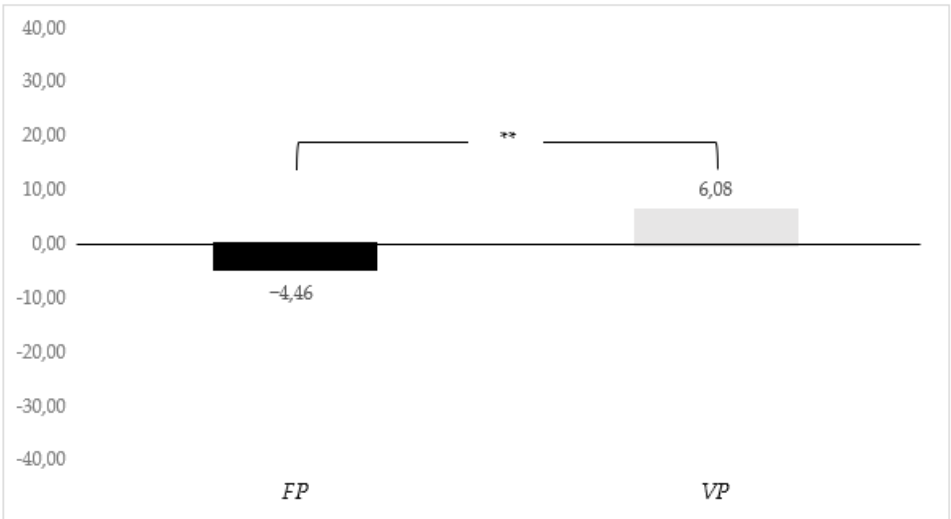
Figure 2. Distribution functions of effort choices in 𝐹𝑃 vs. 𝑉𝑃 . Figure 3 displays participants’ choice of activity level, where a mean activity level a > 0 indicates that participants on average chose to help their group members, and a mean activity level a < 0 indicates that participants on average chose to sabotage their group members. On average, participants in the fixed-prize tournament FP , in fact, chose to sabotage their group members ( a FP = − 4.46), while participants in the variable-prize treatment VP chose to help their group members ( a VP = 6.08 ) . The difference is statistically highly significant at the 1% level.